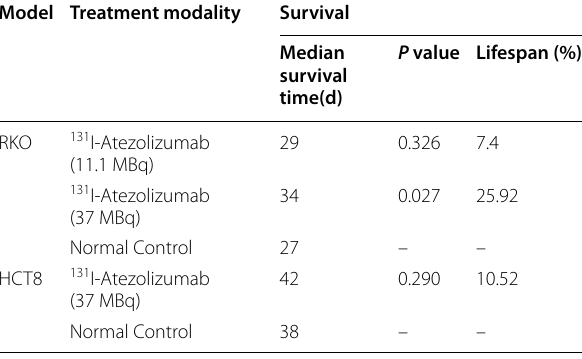
P values were estimated between the experimental and normal control groups by log-rank test, P < 0.05 indicated significance Percentage increase in lifespan was expressed as (the median survival time of treated/the median survival time of control